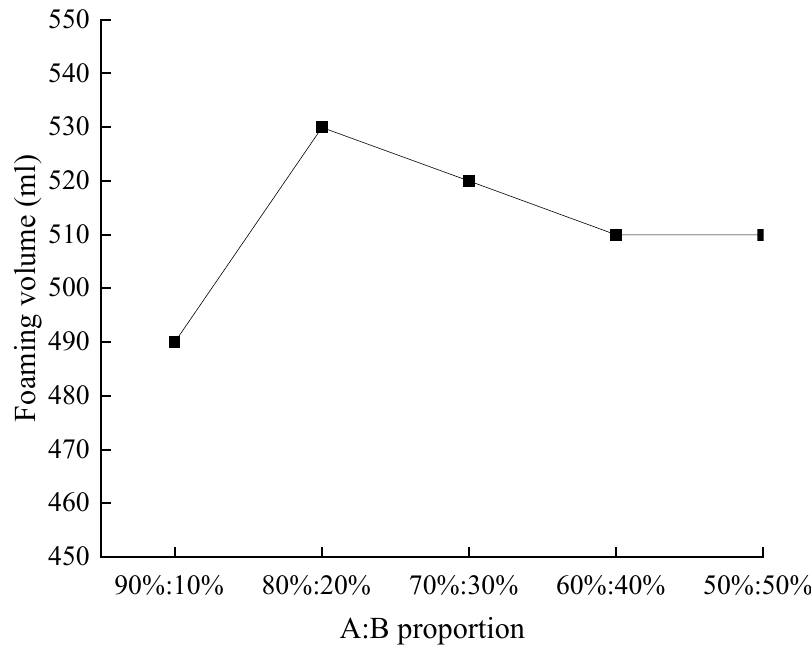
Figure 4. A/B Complex System Foaming Quantity Diagram.